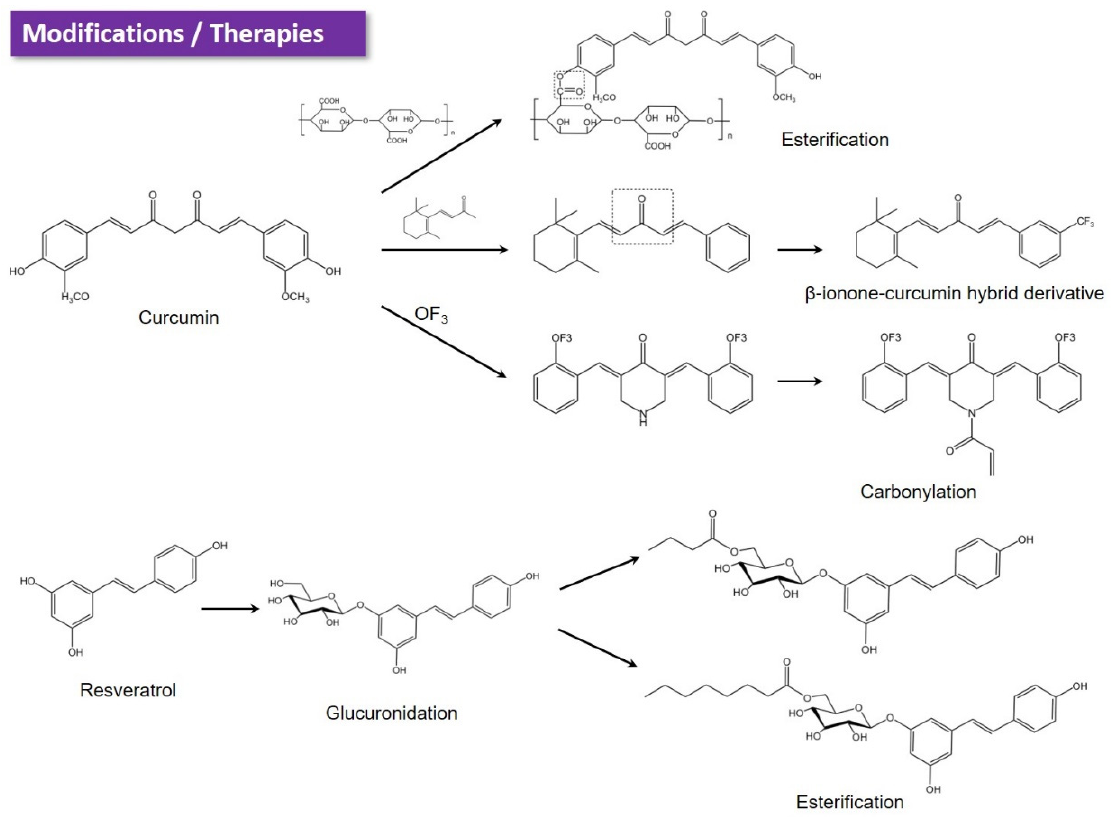
Figure 5 . The application of the modification of polyphenols in IBD therapy. Many chemical modifications, including esterification, glycosylation, and other chemical synthetic modification, can enhance metabolic stability, water solubility, and bioavailability by changing the structure of polyphenols, thus promoting anti-inflammation and antioxidation.